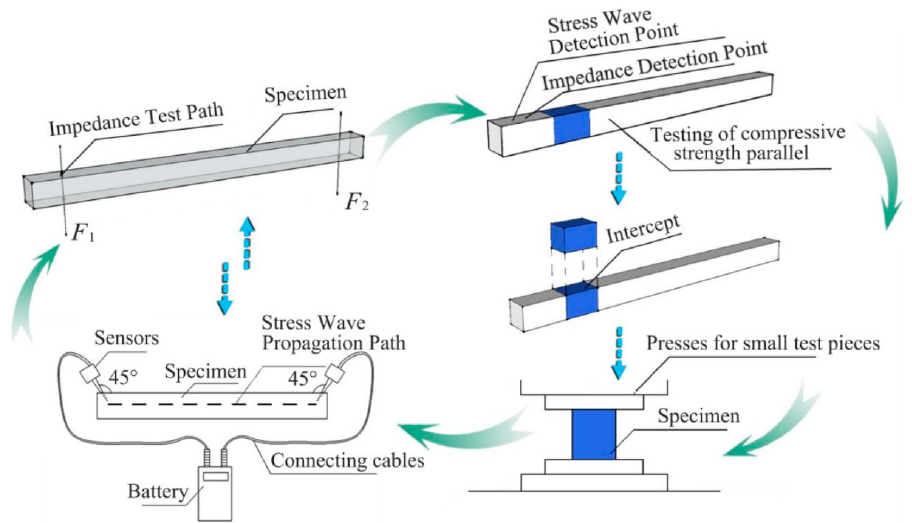
Figure 9. Small specimen test data acquisition flowchart.